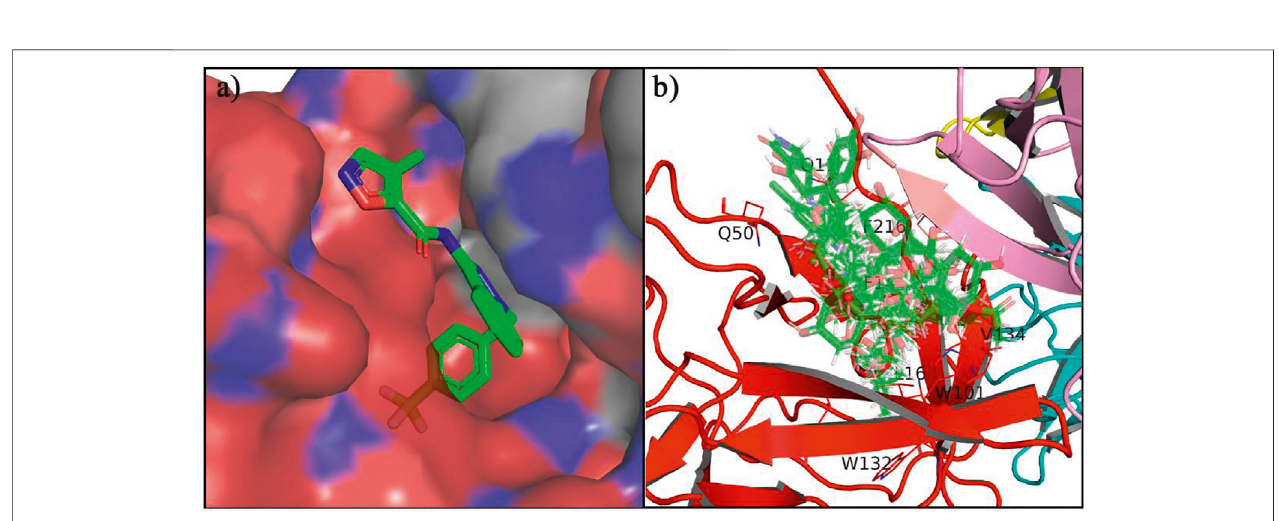
FIGURE 4 | (A) The binding pocket of Fascin with inhibitor NP-G2-029; (B) The molecular docking results for 18 small-molecules.